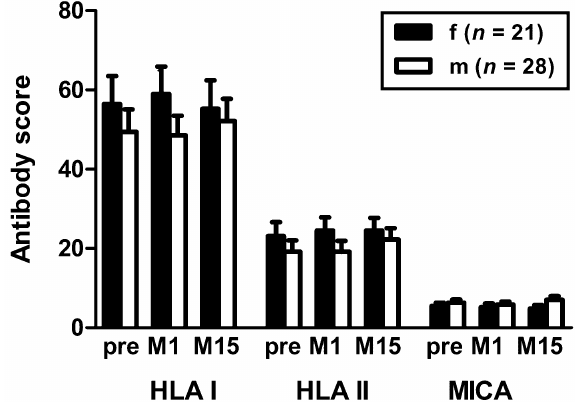
Figure 3. Comparison of HLA/MICA antibodies in female and male kidney transplant recipients of a